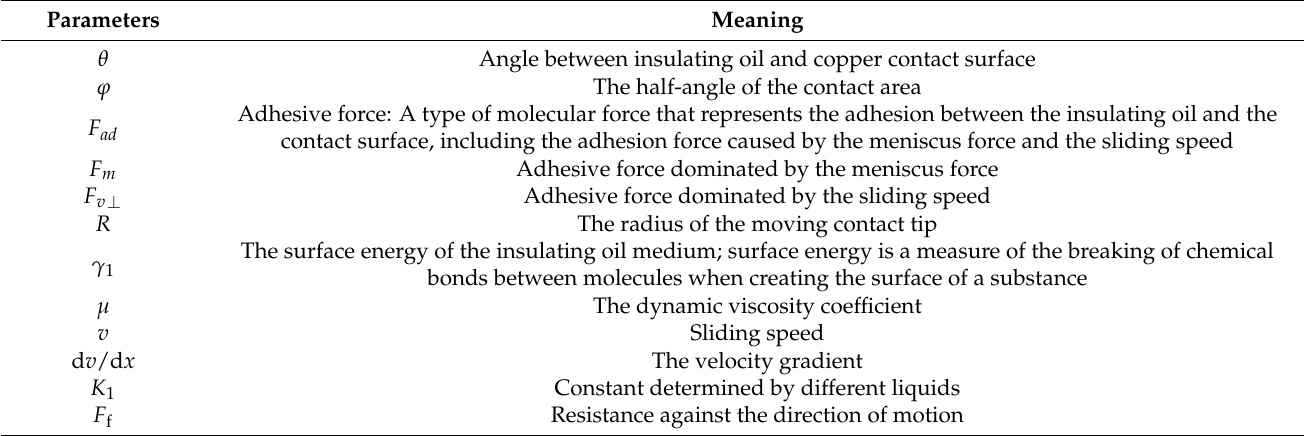
Adhesive force dominated by the meniscus force Adhesive force dominated by the sliding speed The radius of the moving contact tip bonds between molecules when creating the surface of a